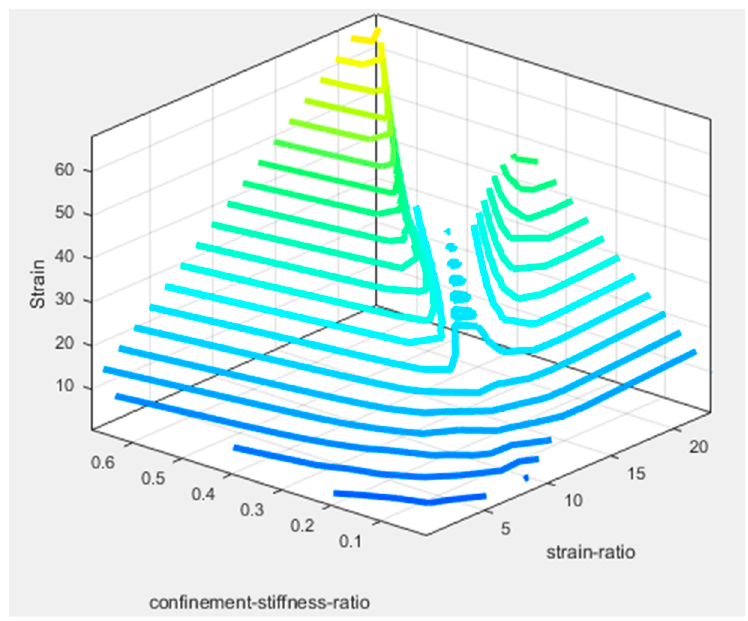
Figure 7. Variation of strain versus strain ratio and confinement stiffness ratio for the optimal ANFIS-SC model.